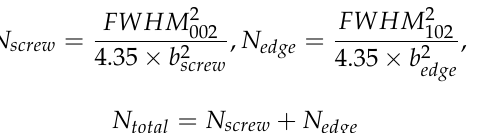
Figure 1. ( a ) Schematic cross-sectional structure of the p-GaN gate HEMT with an Al 0.5 GaN etch- stop layer design. ( b ) p-GaN etch depth versus the etch duration and TEM image after etching (in- set).